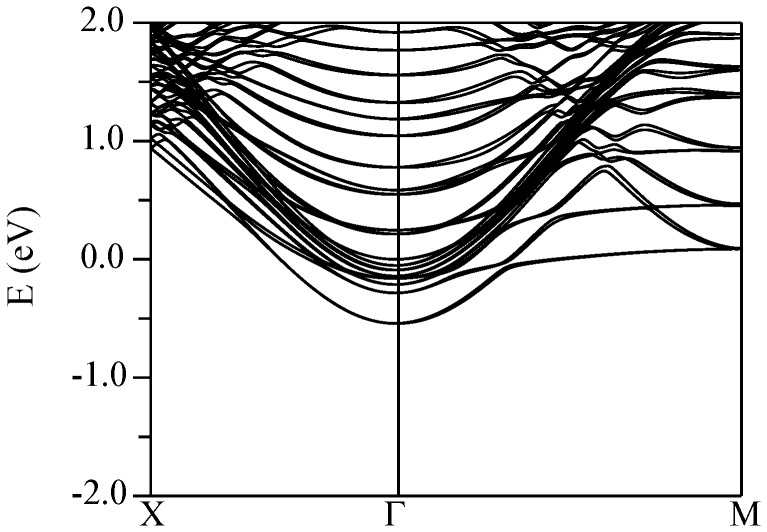
Calculated conduction band structure of the relaxed (KTaO3)//(CaSnO3) supercell (see text) using the TB-mBJ potential.The Fermi energy is at 0 eV. Spin orbit is included.